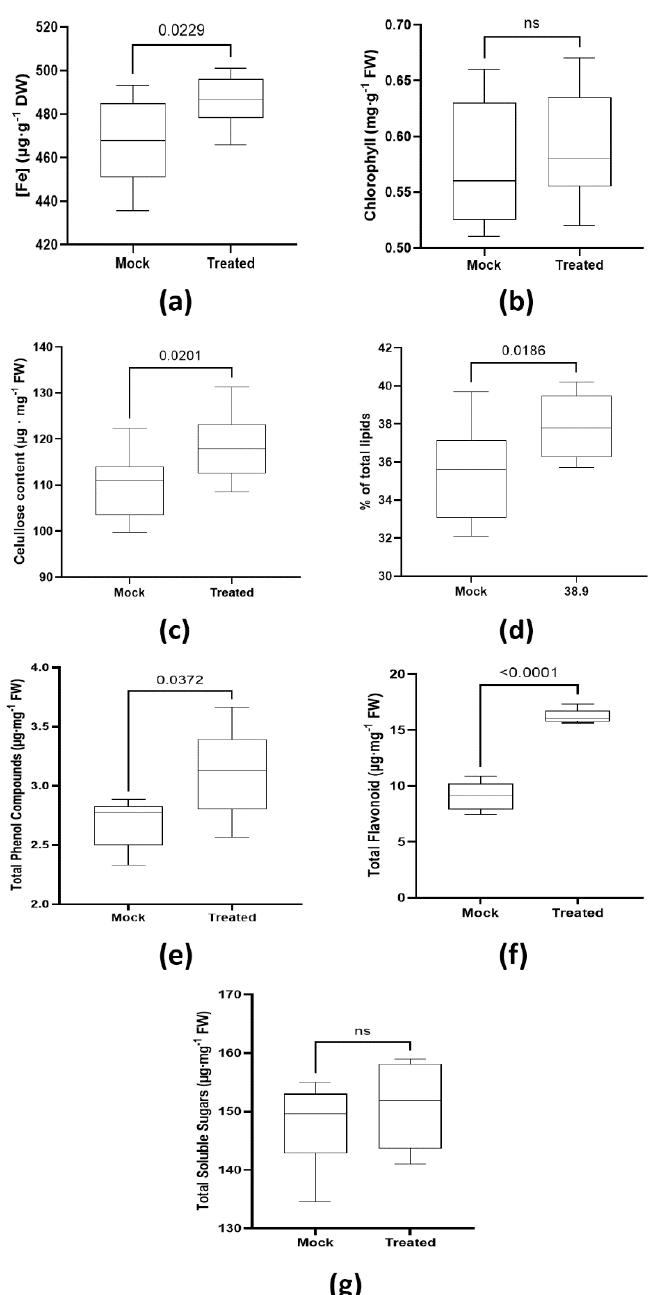
Figure 4. Plant-growth-promotion key metabolite determination. The panel shows the determination of different compounds related to the bacteria-mediated plant growth-promotion process. Thus, ( a – f ) boxplots show the iron content ( a ) and the total chlorophyll content ( b ); the total cellulose ( c ) and lipid proportion ( d ); total phenol ( e ) and flavonol content ( f ); and the total soluble sugar content ( g ). Three repetitions of three replicas (n = 9) were prepared for this test. All the boxplots and violin plots in this figure show representative data from three independent experiments (each one with n = 9 biologically independent samples). Whiskers represent the minimum to maximum data range, and the median is represented by the central horizontal line. The upper and lower limits of the box outline represent the first and third quartiles. Dots in violin plots represent the dispersion of each sample recorded. Error bars represent s.d., including p -value when they were significant, or ‘ns’, when they were not significant.